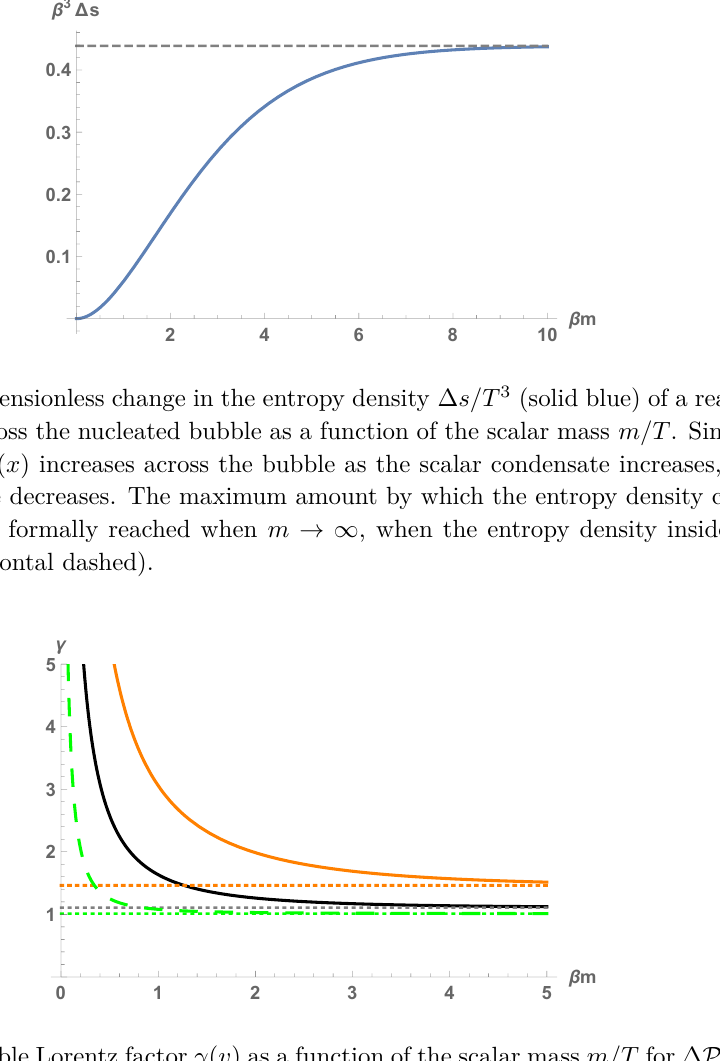
Figure 4 . The bubble Lorentz factor γ ( v ) as a function of the scalar mass m/T for ∆ P = − 0 . 01 /β 4 (green dashed), ∆ P = − 0 . 1 /β 4 (solid black) and ∆ P = − 0 . 5 /β 4 (solid